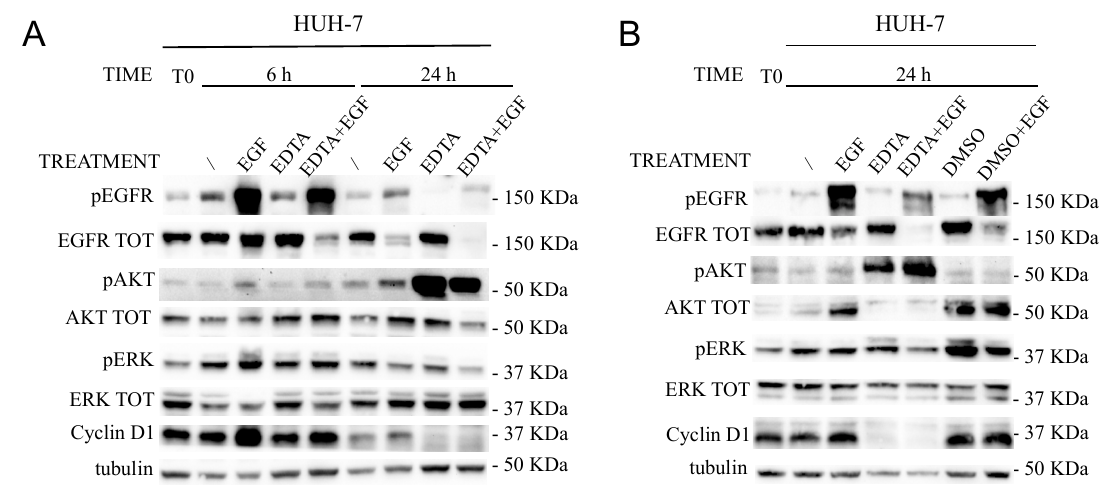
Figure 6. Starved HUH-7 cells (T0) were left untreated (/) (0% FBS as CTR) or treated with 100 ng/mL EGF, 2 mM EDTA, 0.5% DMSO, or combined compounds (as indicated in the figures). The cell signaling cascade was analyzed by western blot after 6 h ( A , B ) and 24 h ( B ).